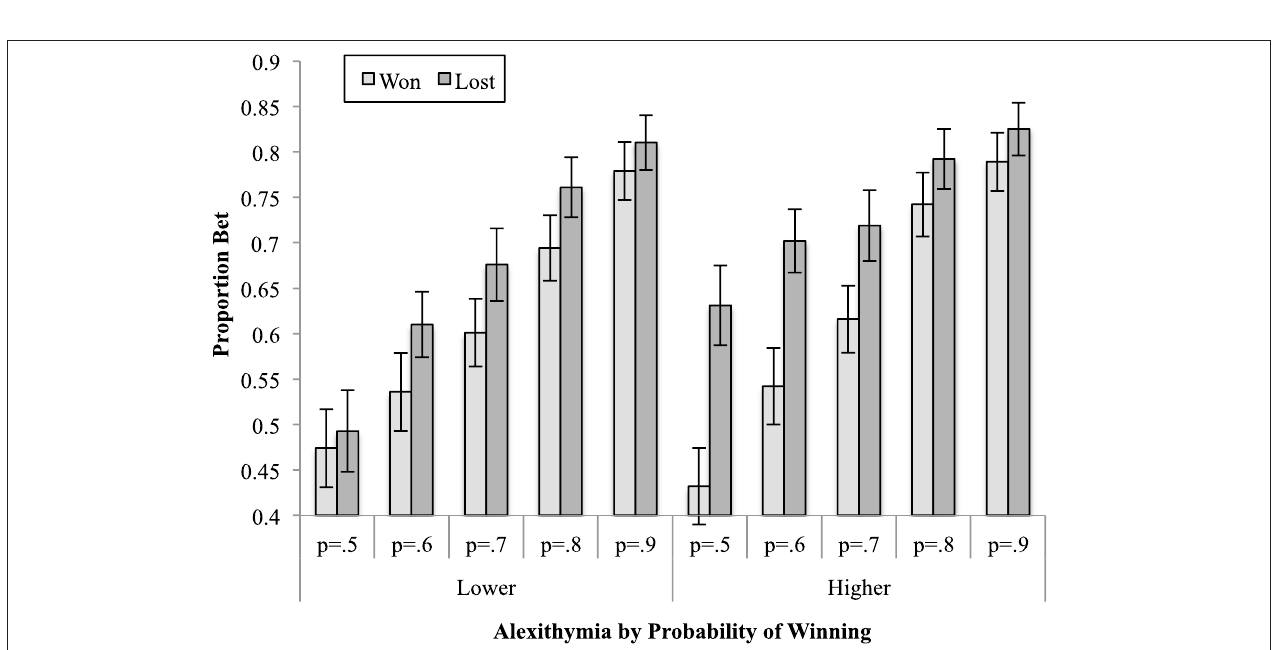
FIGURE 4 | The means (and standard errors) of the proportion bet for the outcome of the previous trial by the probability of winning on the current trial.